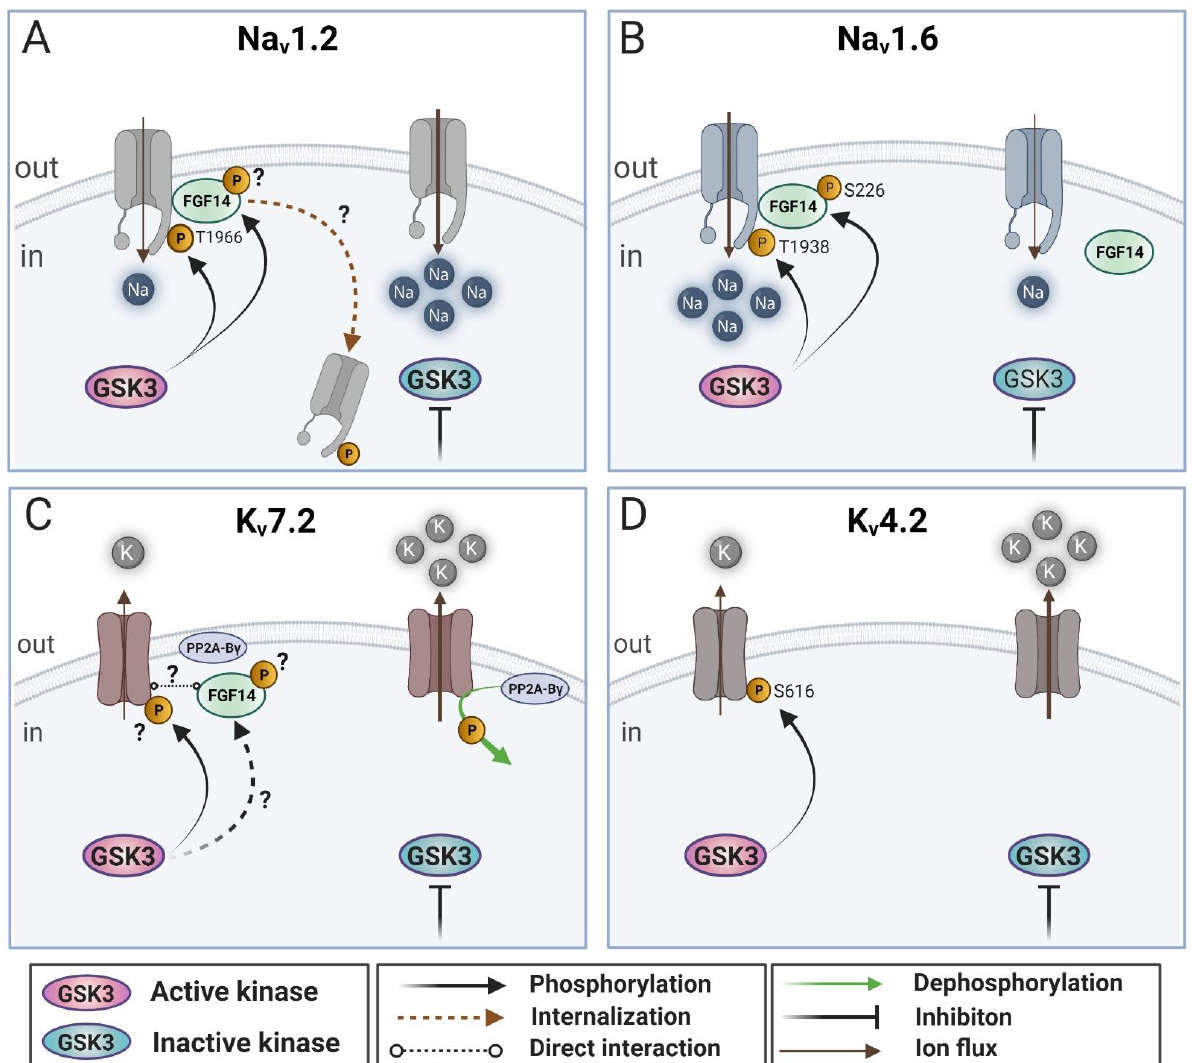
Figure 1. GSK3β -mediated phosphorylation as a regulation of voltage-gated cation channels. ( A ) Figure 1. GSK3 β -mediated phosphorylation as a regulation of voltage-gated cation channels. Effects of GSK3β -mediated phosphorylation on the Na v 1.2 channel. Active GSK3β phosphorylates ( A ) Effects of GSK3 β -mediated phosphorylation on the Na v 1.2 channel. Active GSK3 β the Na v 1.2 channel at the Th1966 (T1966) residue, which maybe facilitates channel internalization